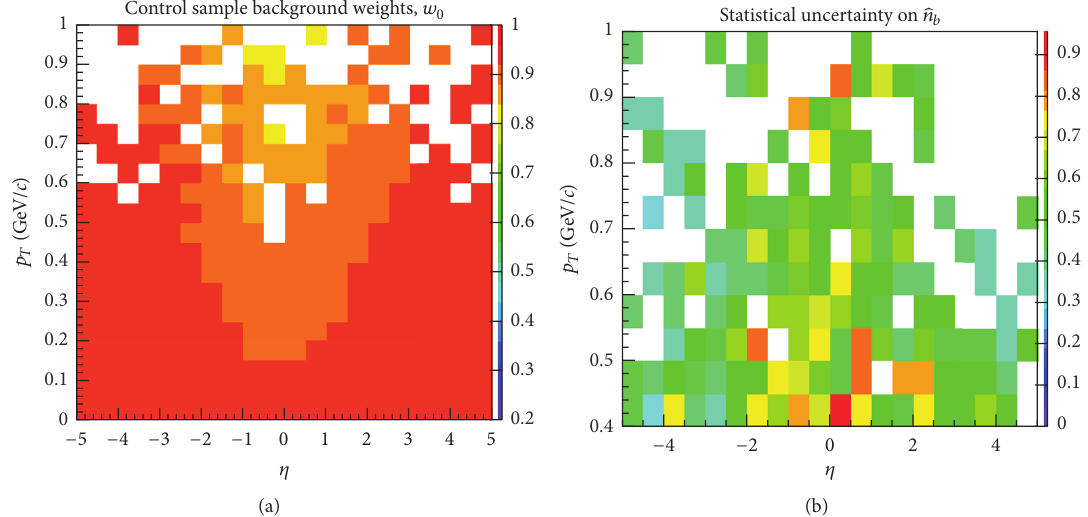
Figure 3: (a) Distribution of 𝑤 0 (𝜂, 𝑝 𝑇 ) , estimated as described in the text. (b) Statistical uncertainty on the estimated number of soft QCD ,representedasaheatmapacrosstheparticle (𝜂, 𝑝 𝑇 ) space,insidetheeventchosentoillustrateourresults.Additionalinformation particles, 𝜎 𝑛 𝑏 is provided in the